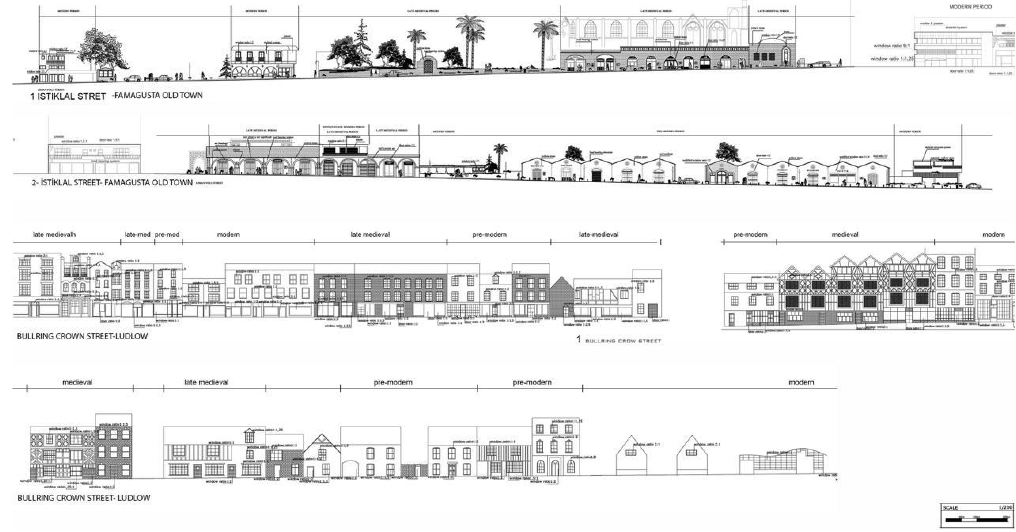
Figure 2 Façade Typology of Famagusta and Ludlow, ( Cömert 2013